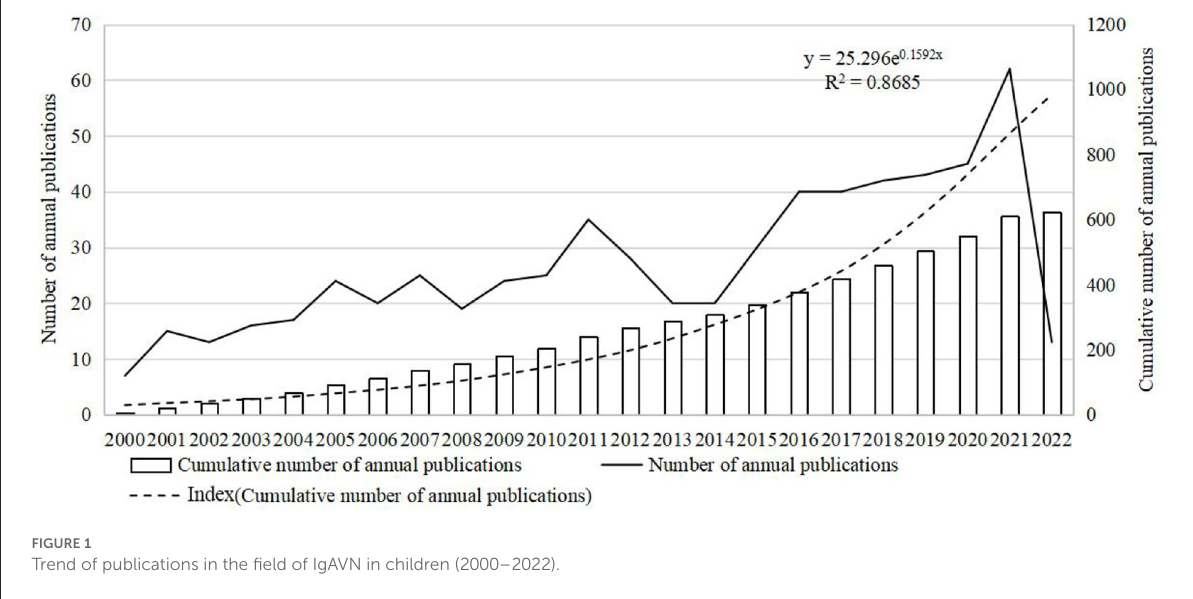
FIGURE1 Trend of publications in the field of IgAVN in children (2000–2022).